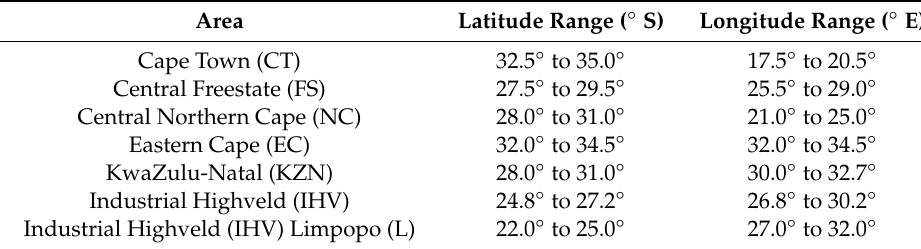
Table 1. Vertically profiled areas and their geographic